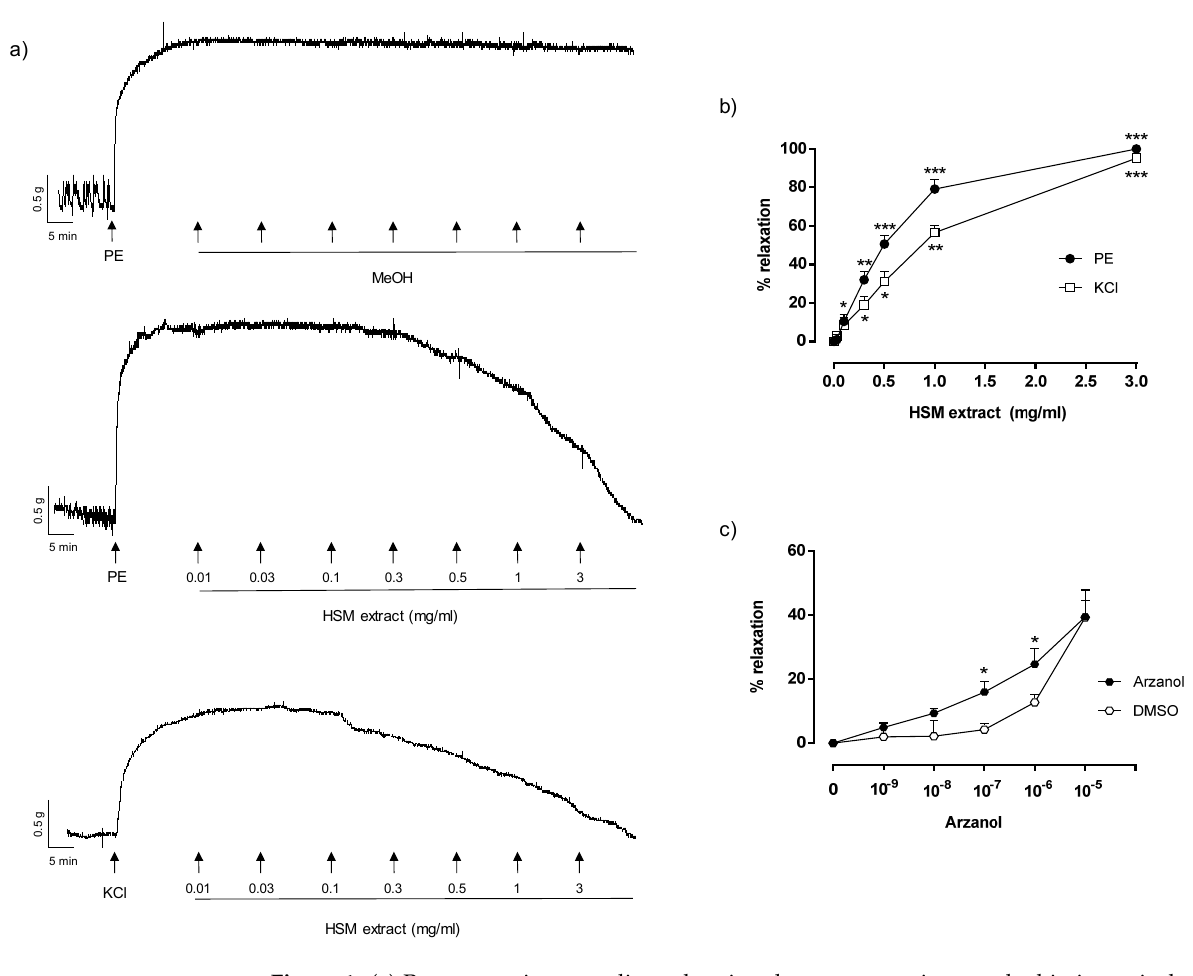
Figure 1. ( a ) Representative recordings showing the precontractions evoked in intact isolated rat aorta rings by PE (1 μ M) or KCl (80 mM) and the effects induced by MeOH and H. stoechas extract (HSM; 0.01–3 mg/mL) on these contractions. ( b ) The relaxant effects of different concentrations of extract (mg/mL) on PE- or K+-induced contractions of isolated rat aorta rings (PE, F = 219, p < 0.0001; KCl, F = 187.6, p = 0.0001). * p < 0.05, ** p < 0.01 and *** p < 0.001 vs. control values (basal tone). ( c ) p < 0.05 vs. DMSO values. Data points are mean ± SEM ( n = 6–8).